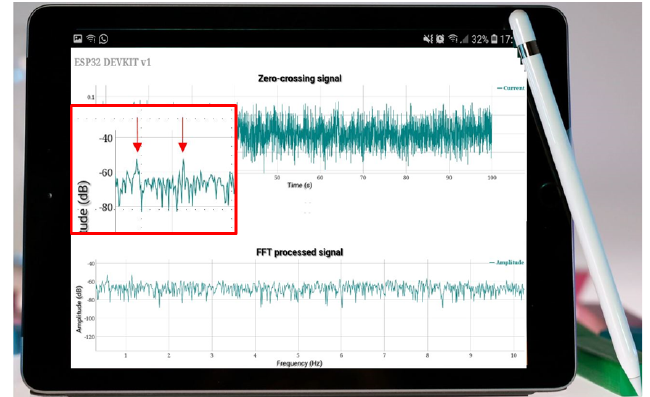
Figure 8. Diagnostic spectrum generated with the proposed approach, displayed on a portable device for easy access by maintenance